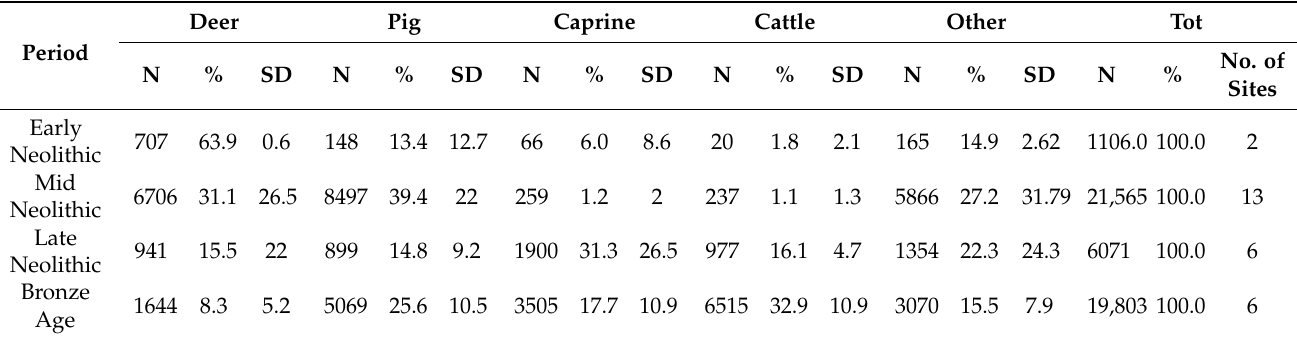
Table 2. Average taxonomic abundance for Deer, Pig, Caprine, Cattle, and Others by NISP per time period. Data are presented in raw numbers (N) and percentages (%). Data sources are available in Appendix A. Differences between sites are highlighted using Standard Deviation